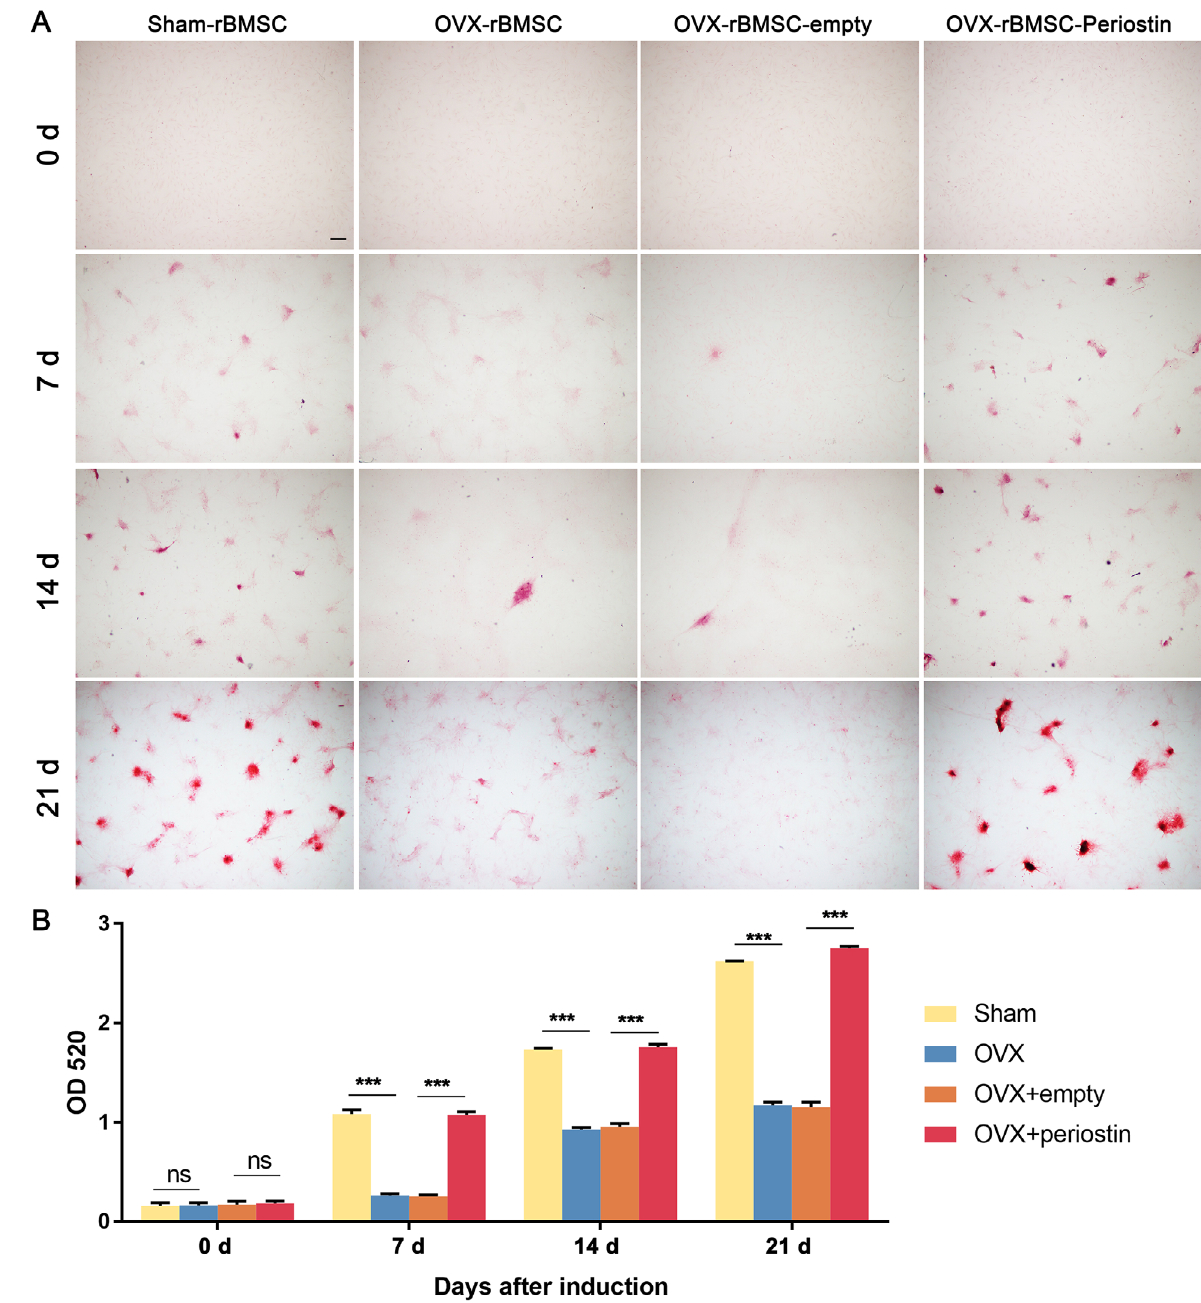
Figure 6 ‒ Overexpression of periostin increased ARS staining in OVX-BMSCs. (A) Representative images of ARS staining of the indicated groups on day 0, day 7, day 14 and day 21 after osteogenesis induction. The images are from 1 of 3 independent experiments, magnification × 40, scale bar = 200 μm. (B) Graph showing quantitative analyses of ARS of the indicated groups on day 0, day 7, day 14 and day 21 after osteogenesis induction. Data are presented as the mean ± SD of 3 independent experiments. ns, not significant. *** P < 0.001; One-way